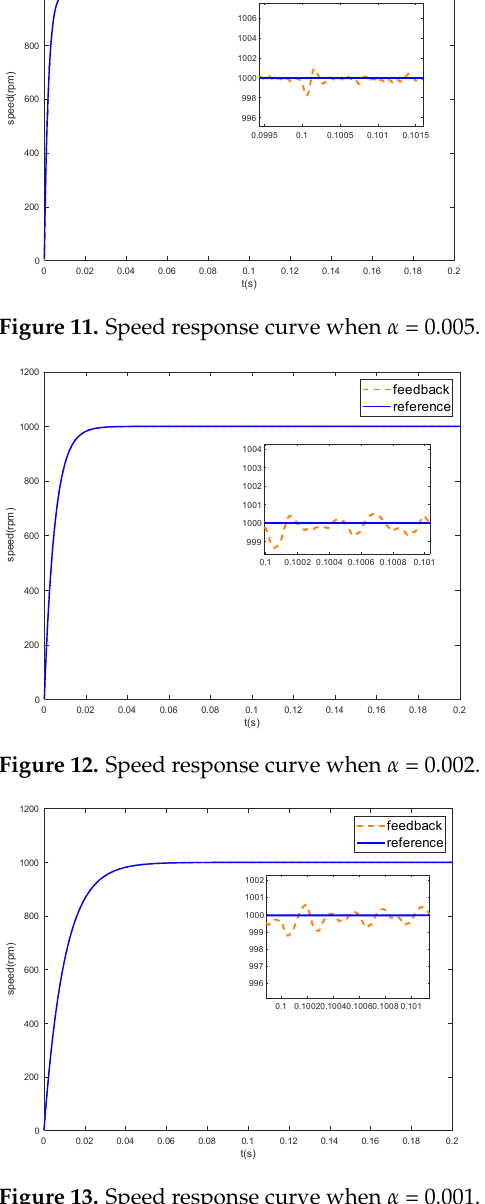
Figure 13. Speed response curve when α = 0.001.